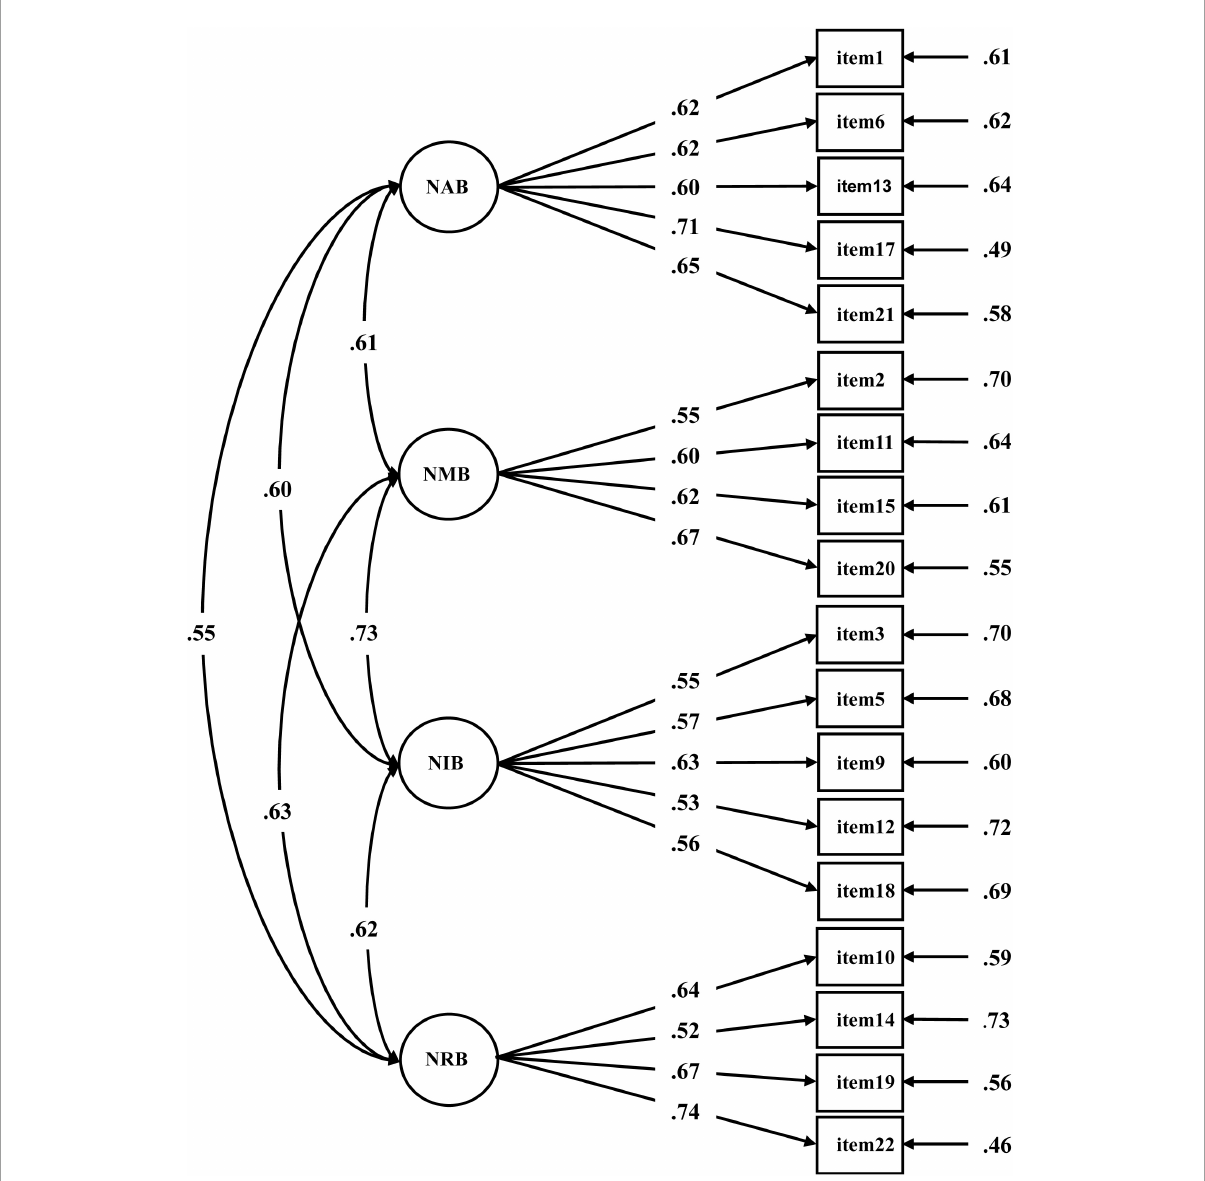
FIGURE1 The four-factor confirmatory factor analysis model of the negative cognitive processing bias scale for the validation set ( n = 3,034). Each number alongside the lines indicates standardized factor loading. NAB, negative attention bias; NMB, negative memory bias; NIB, negative interpretation bias; NRB, negative rumination